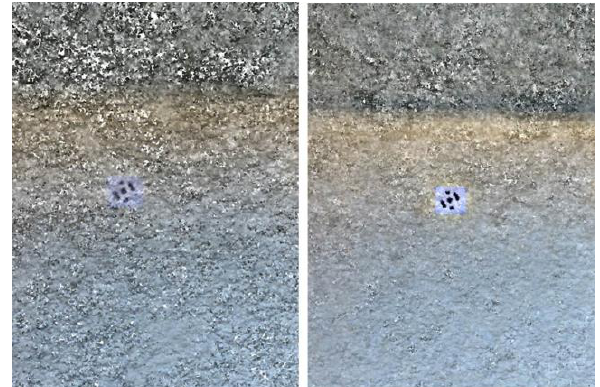
Figure 5. Pointcloud of the white wall (fisheye lens) before (left) and after (right) the post-processing on Photoshop After having weighed the pros and cons of these two procedures applied only to the southern wall, it was finally decided to reconstruct the digital model of the entire cloister using the photos taken with the normal lens (which provided the best degree of detail).